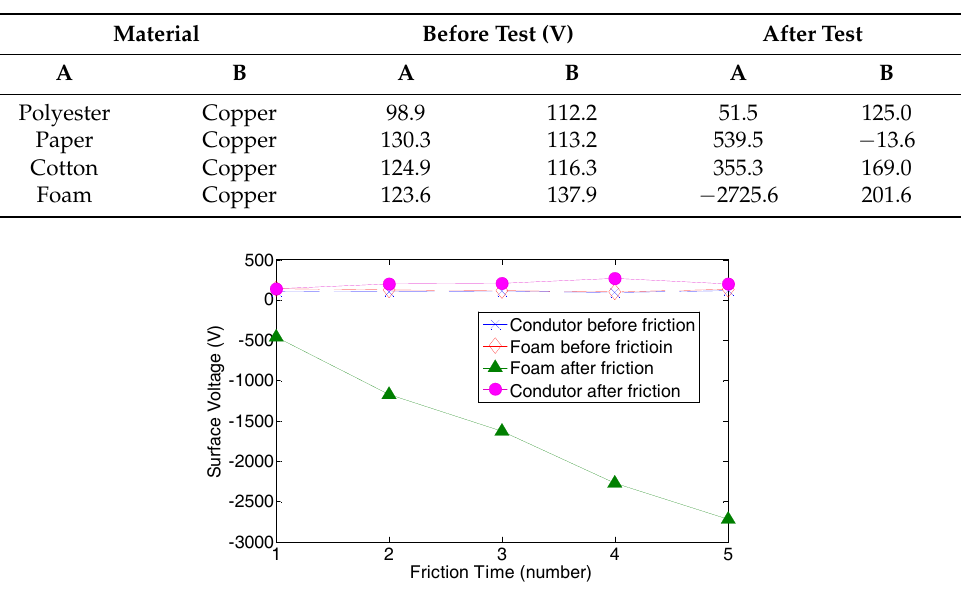
Figure 8. Triboelectric property of foam.